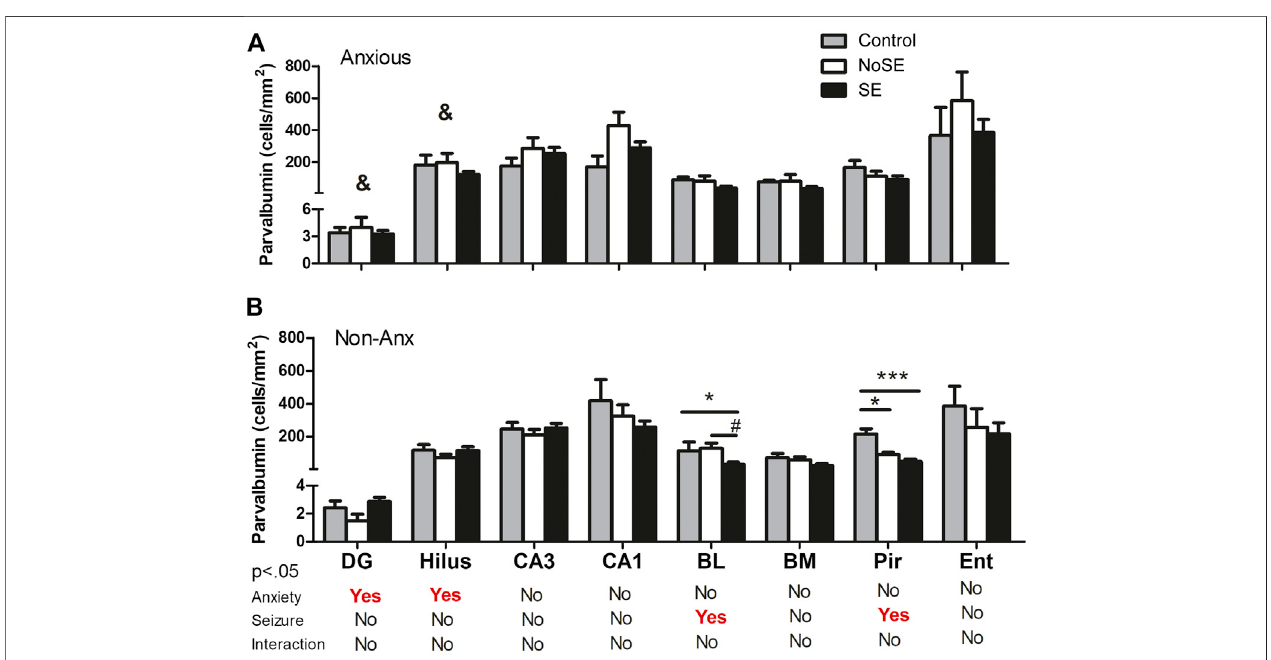
FIGURE 7| Density ofPV in several regions 90days after pilocarpine injection. (A) Anxious group (B) Non-Anxious group. The PV density in the dentate gyrus and hilus was in fl uenced by the anxiety (&A vs B). Also, pilocarpine injection and SE development in fl uenced PV density in the basolateral amygdala and piriform cortex, but only in Non-Anx group (B) . Values: mean ± SEM. Two-Way ANOVA, Bonferroni post hoc test, p < 0 .05 &Anxious vs Non-Anxious; SE group vs Controls (* p < 0.05; *** p < 0.001) and SE group vs NoSE ( # p < 0.05); Interaction p > 0.05. Parvalbumin, PV; DG, dentate gyrus; BL, basolateral amygdala; BM, basomedial amygdala; Pir, piriform; Ent, entorhinal cortex.